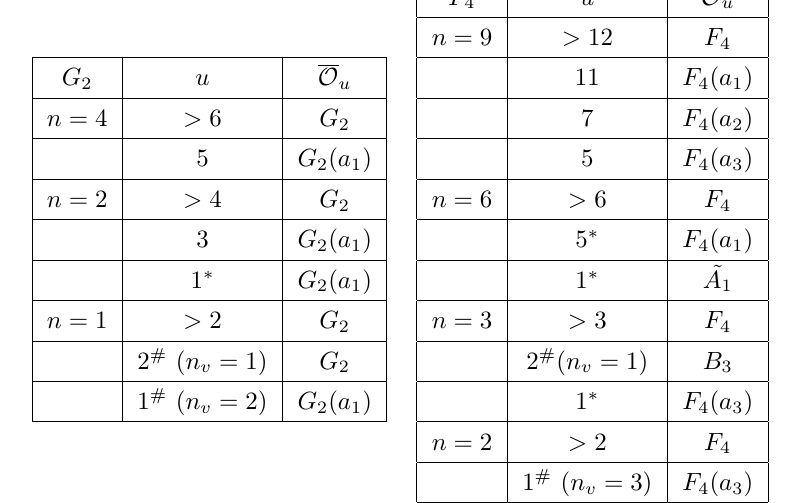
− 2 . The one with n is the number v